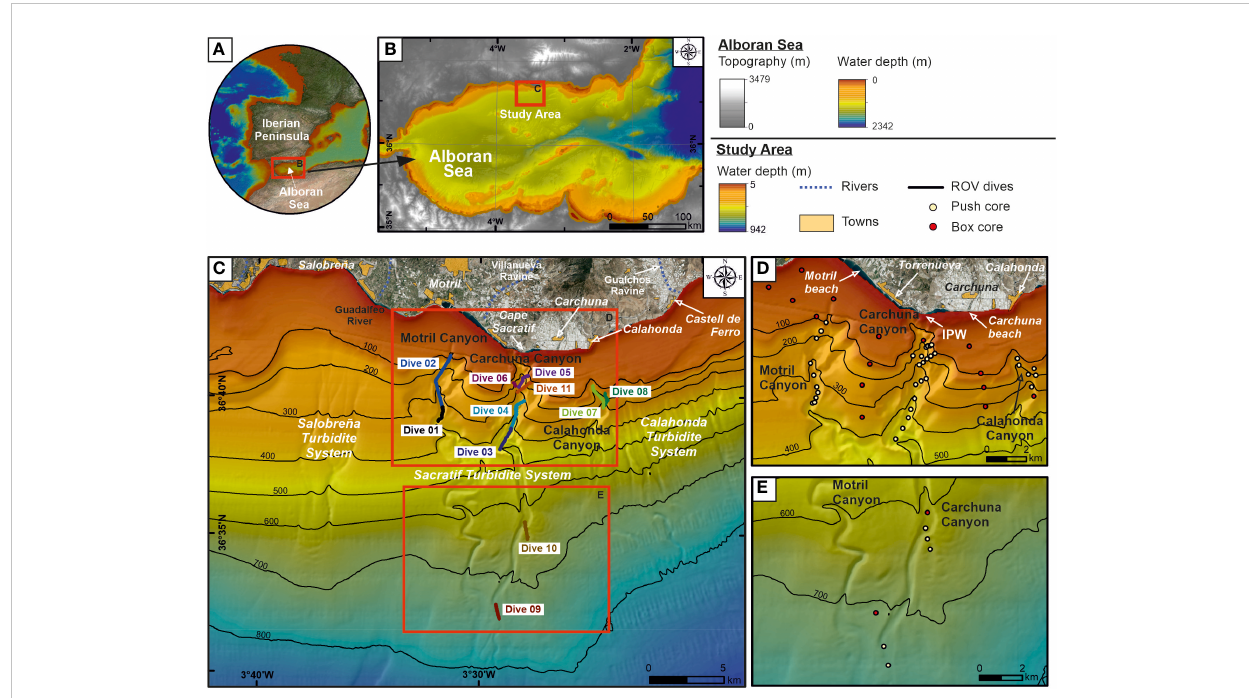
FIGURE 1 (A) Geographic location of the study area in the southern Iberian Peninsula. (B) Overview topo-bathymetric map of the Alboran Sea indicating the location of the study area on the northern margin. (C) Bathymetric map ( “ Ministerio de Pesca, Agricultura y Alimentacio ́ n ” , Spanish government) of the study area showing the three studied submarine canyons and the location of the ROV underwater dives (Dives 01 to 11) executed along the canyon thalwegs and fl anks. Inland aerial photography shows the streams and towns. (D, E) Zoomed-in bathymetric maps of the study area showing the location of sediment cores collected in the canyons during the oceanographic survey ALSSOMAR-S2S 2019. IPW, infralittoral prograding wedges. Bathymetric contours in